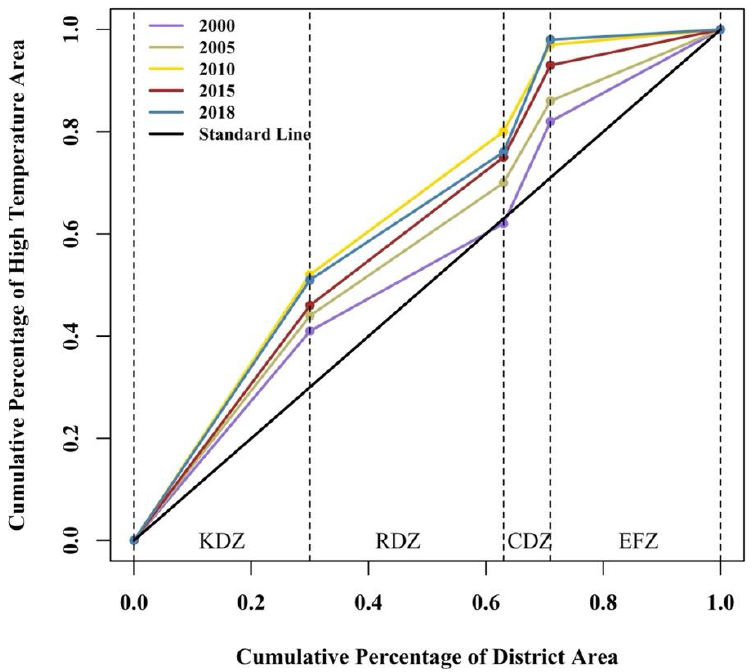
Figure 5. Spatial Lorenz curves of Xi’an’s four functional zones in 2000, 2005 , 2010, 2015, and 2018. The standard line indicates an equal distribution of areas with relatively high temperature proportions in each district. The closer the spatial Lorenz curve is to the standard line, the more equally distributed the area is with relatively high temperatures. On the contrary, a departure from the standard line represents inequality in the area with a relatively large temperature distribution.